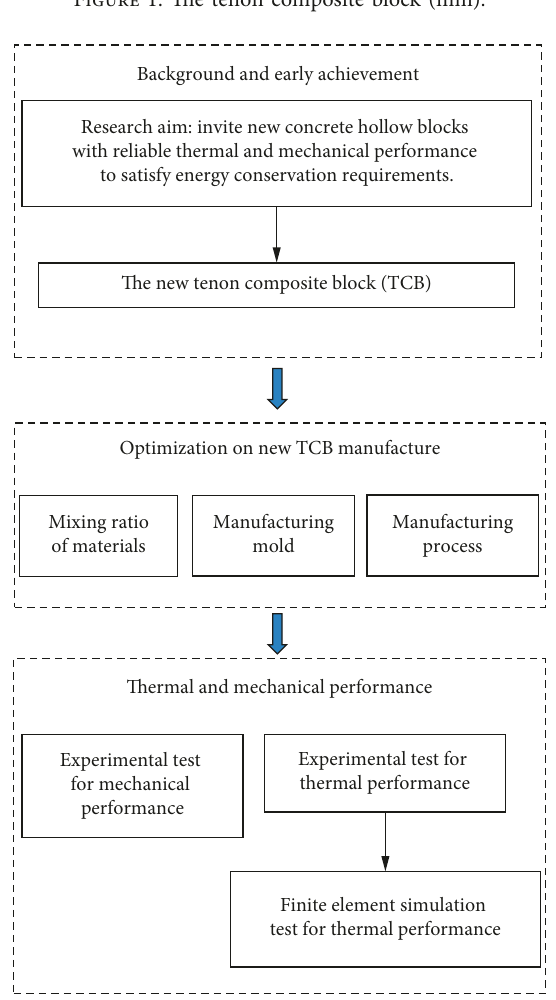
Figure 2: Main contents and study procedure of this